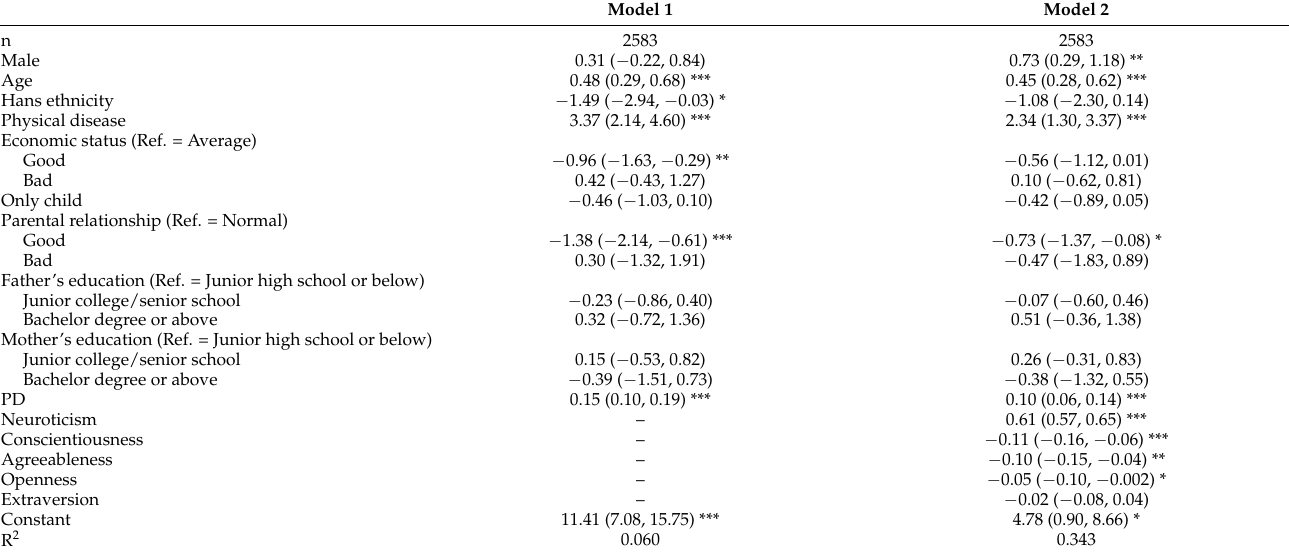
Table 3. Linear regression for the factors associated with mental health ( β (95%